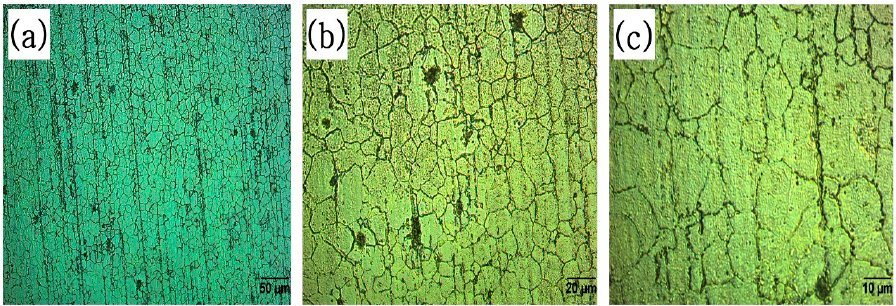
Figure 4. Optical micrograph of a longitudinal cot of the as-received AZ91D wire at: ( a ) 20 × ; ( b ) 50 × ; ( c ) 100 × .